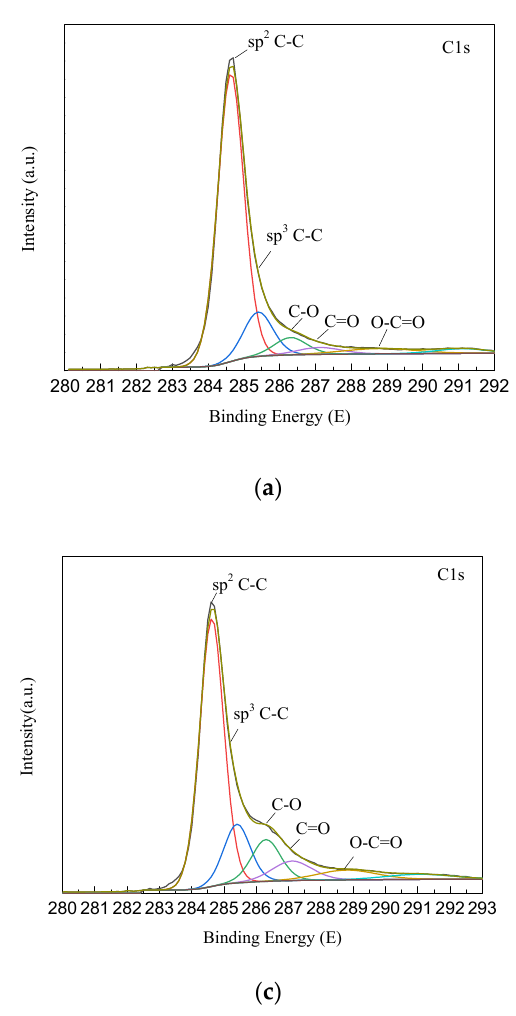
Figure 2. XPS image of MWCNTs/PVDF conductive membrane: ( a ) Conductive membrane without PVA; ( b ) Conductive membrane with PVA added; ( c ) Conductive membrane crosslinked with GA.